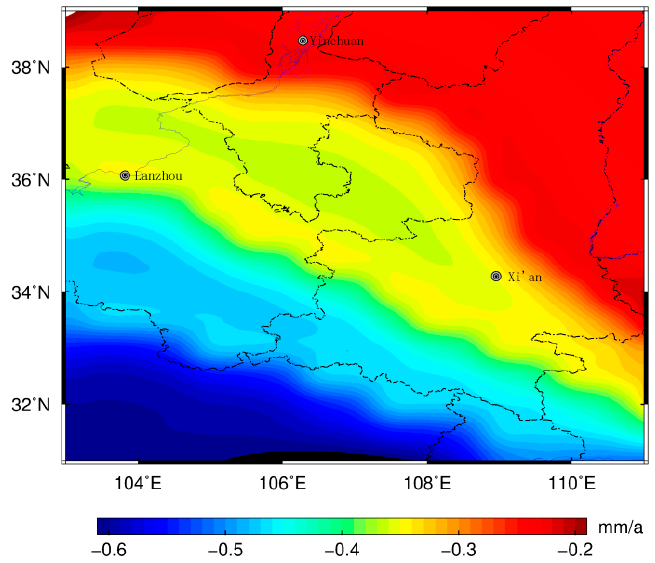
Figure 3. Linear rate every year for vertical deformation from terrestrial water load in SGN from 2010 to 2014.